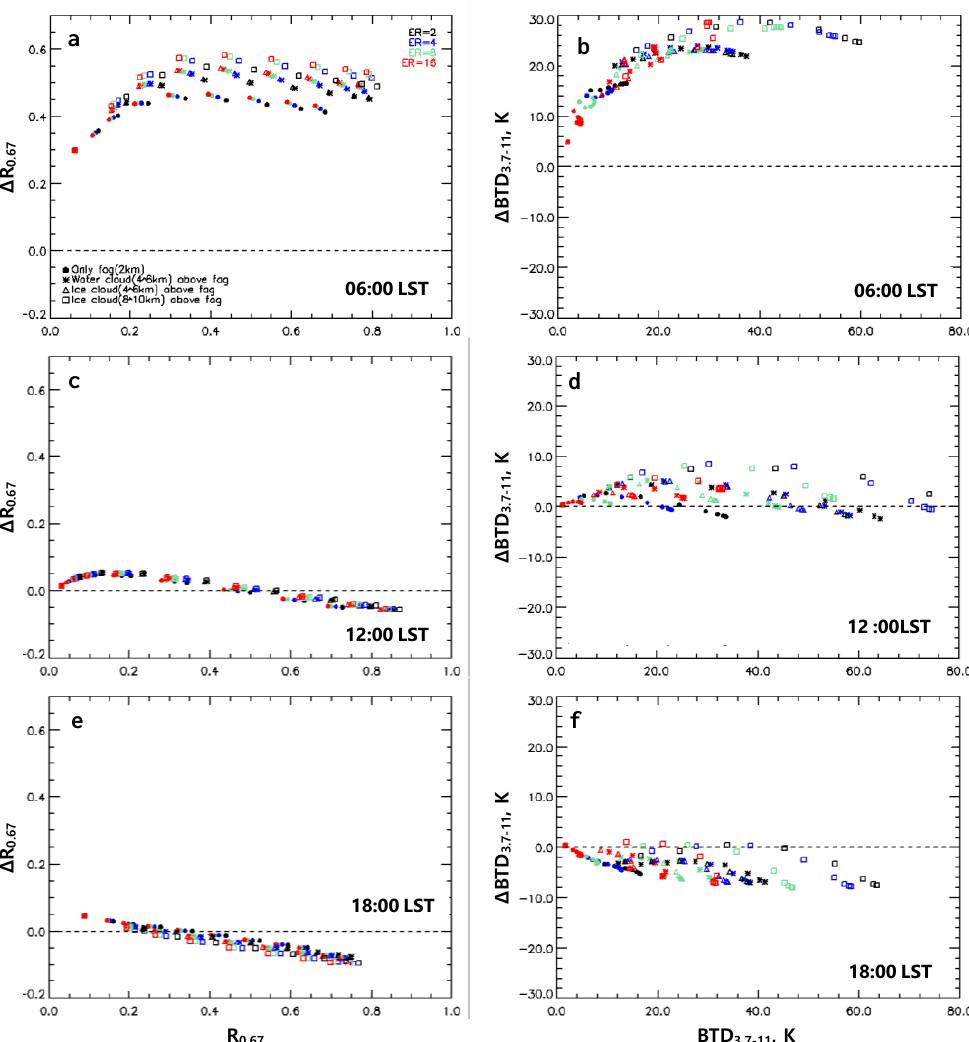
Figure 5. Simulated results of ∆ R 0.67 vs R 0.67 ( a , c , e ) and ∆ BTD 3.7-11 vs BTD 3.7-11 ( b , d , f ) under the Radiative Transfer Model (RTM) conditions of Table A4. Each simulation on 18 July 2014 was shown in the dual-satellite relationship of FY-2D and COMS at three different times: 06:00 LST (for dawn), 12:00 LST (noon), and 18:00 LST (for dusk). The reflectance and BTD 3.7-11 simulations are presented in the left- and right-hand columns, respectively. The clear-sky value is shown in the leftmost one (red square) in each figure.